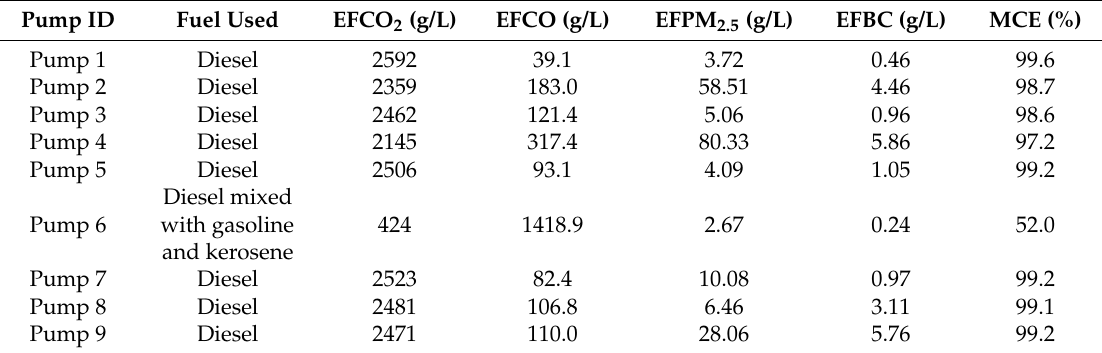
Table 2. Summary of emission factors for all measured pumps.